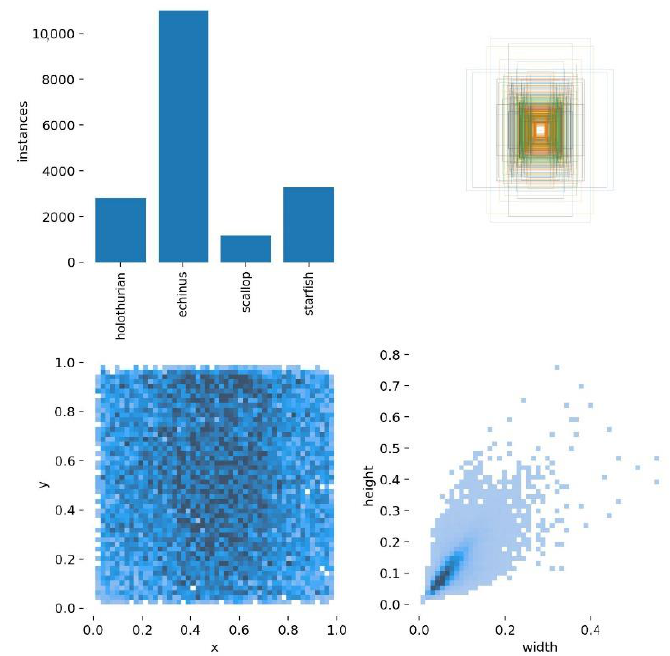
Figure 7. Data set label analysis.